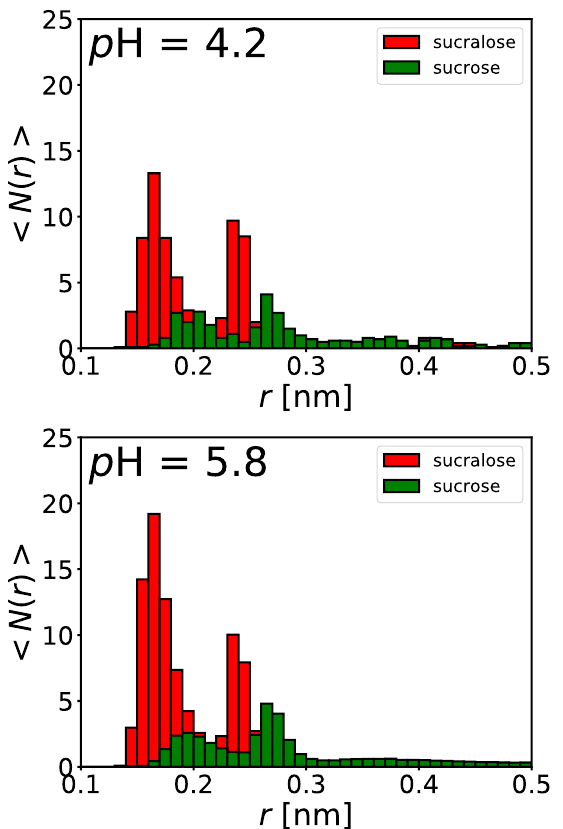
Figure 8. Sucralose has a greater propensity towards the protein surface. Average number of closest sugar atoms from the closest protein atom (hydrogens included) in the vicinity of the protein surface grouped into 0.01 nm wide bins. Only the closest oxygen atom of each sugar molecule was considered. All for 25